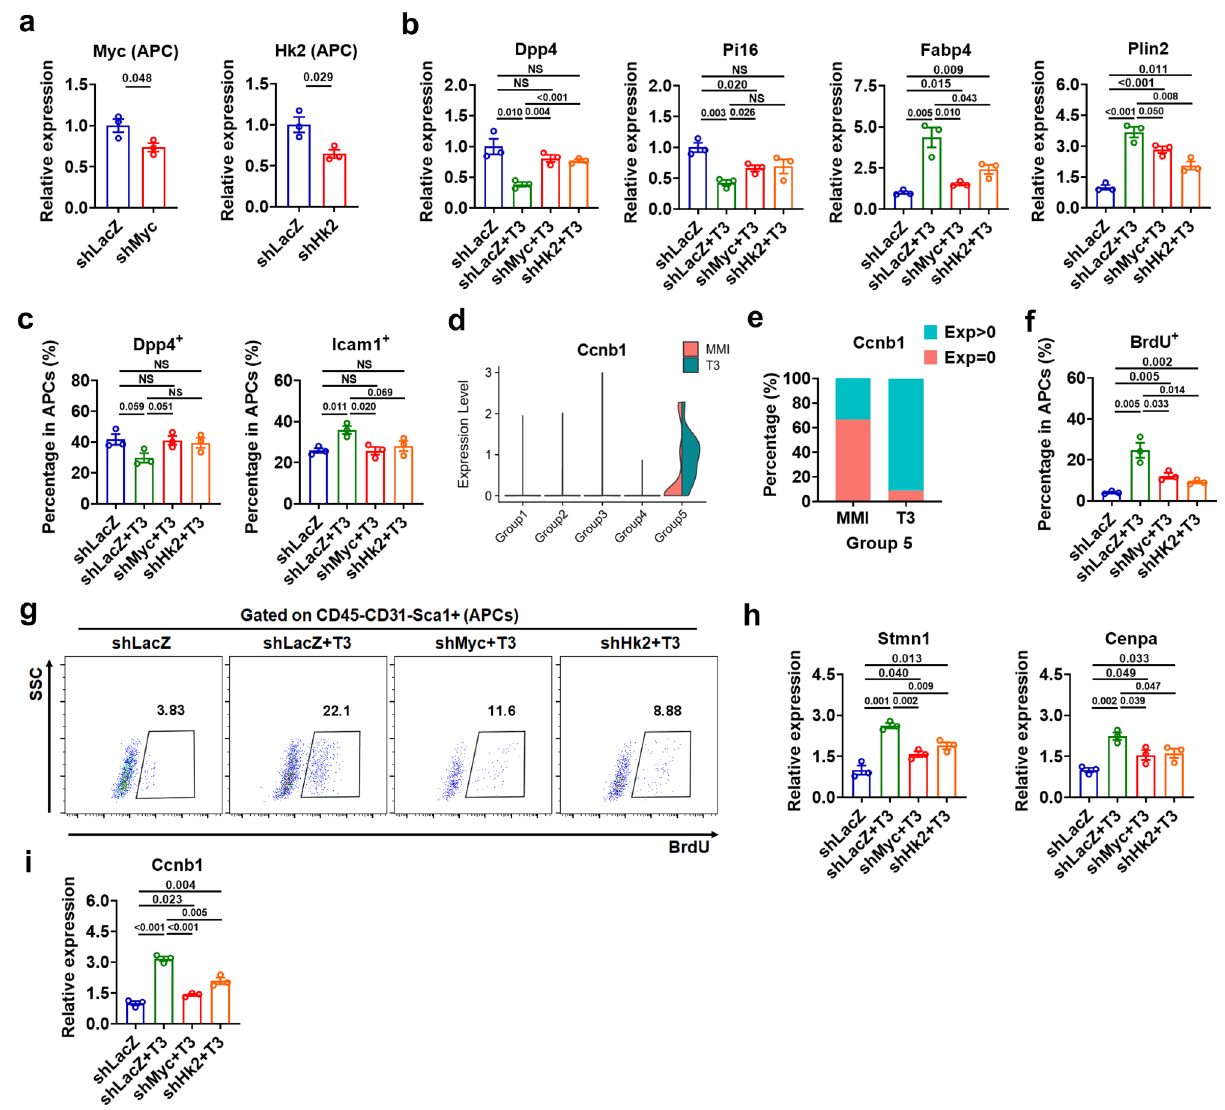
Fig. 9 Knockdown of Myc or Hk2 attenuates the T3 effect on cell state transition and cell cycle progression. a qRT-PCR analysis of Myc or Hk2 in APCs from iBAT of shRNA-injected mice ( n = 3). b qRT-PCR analysis of selected Group 1-speci fi c genes and Group 2-speci fi c genes in APCs from iBAT of shRNA-injected mice with daily T3 injection for 4 d ( n = 3). c Percentage of Dpp4 + APCs, Icam1 + APCs in iBAT of shRNA-injected mice with daily T3 injection for 4 d ( n = 3). d Violin plots showing the expression levels and distribution of Ccnb1 , split by “ orig.ident ” (MMI group and T3 group). e Comparison of the percentage of Ccnb1 positive cells in Group 5 cells between MMI group and T3 group. f Percentage of BrdU + APCs in iBAT of shRNA- injected mice with daily T3 injection for 4 d ( n = 3). g FACS plot of the BrdU + APCs in iBAT of shRNA-injected mice with daily T3 injection for 4 d ( n = 3). Cells were pre-gated on live CD45 − CD31 − Sca1 + cells. h , i qRT-PCR analysis of Group 5 markers ( Stmn1 and Cenpa ) ( h ) and G2/M phases marker ( Ccnb1